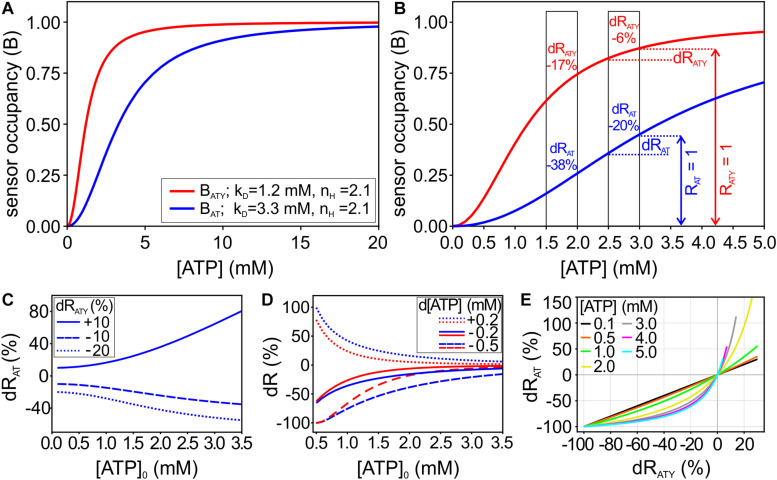
Mathematical framework of the dual nanosensor approach. (A) Binding curves for the ATP sensors ATeam1.03 (AT; blue) and ATeam1.03YEMK (ATY; red), showing the sensor occupancy (B) at different cytosolic [ATP]. (B) Enlargement of A for [ATP] from 0 to 5 mM. The boxes highlight two examples with d[ATP] = −0.5 mM starting at [ATP]0 = 2 mM and [ATP]0 = 3 mM, respectively. Note that RAT = 1 and RATY = 1 (i.e., the sensor signal at the starting [ATP]0, indicated by the vertical arrows for the example of [ATP]0 = 3 mM) correspond to different values of sensor occupancy (B) for both sensors. The resulting relative changes of the sensor signals dRAT and dRATY are given within the boxes. (C) Changes of RAT (dRAT) depending on [ATP]0 at given values of dRATY (dRATY = −10%, −20%, and +10%). (D) A change in [ATP] results in a characteristic pair of signal changes dRAT and dRATY, which depend also on [ATP]0. Shown are examples of d[ATP] = −0.2 mM, d[ATP] = −0.5 mM, and d[ATP] = +0.2 mM. (E) For each [ATP]0, unique pairs of dRAT and dRATY describe a given d[ATP]. Therefore, [ATP]0 can be deduced from pairs of dRAT and dRATY obtained experimentally.